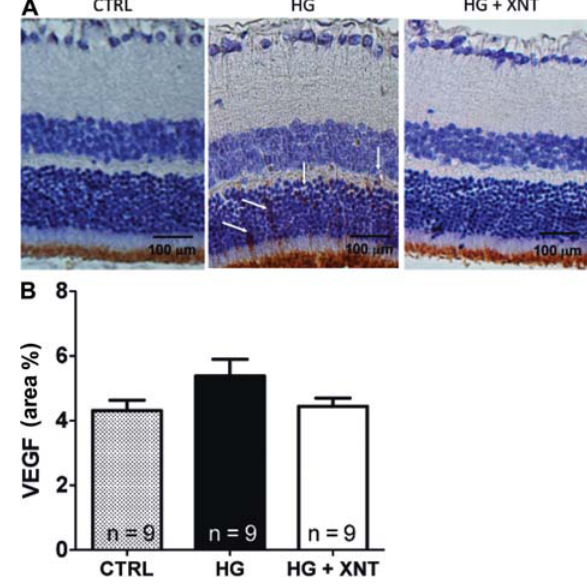
Figure 3. Effects of XNT on caspase-3 expression in retinal ganglion cells (RGC). A , Representative photomicrographs of retinas of control rats (CTRL), hyperglycemic untreated rats (HG) and hyperglycemic treated rats (HG + XNT) showing higher caspase-3 expression in RGC of the HG group (see insets). Rectangular dotted lines delineate the ampli fi ed areas shown in the inset images. B , When the expression of caspase-3 was quanti fi ed, XNT reduced the apoptosis of RGC of HG rats. *P o 0.05 compared to CTRL group; # P o 0.05 compared to HG group (one-way ANOVA followed by the Newman-Keuls test).